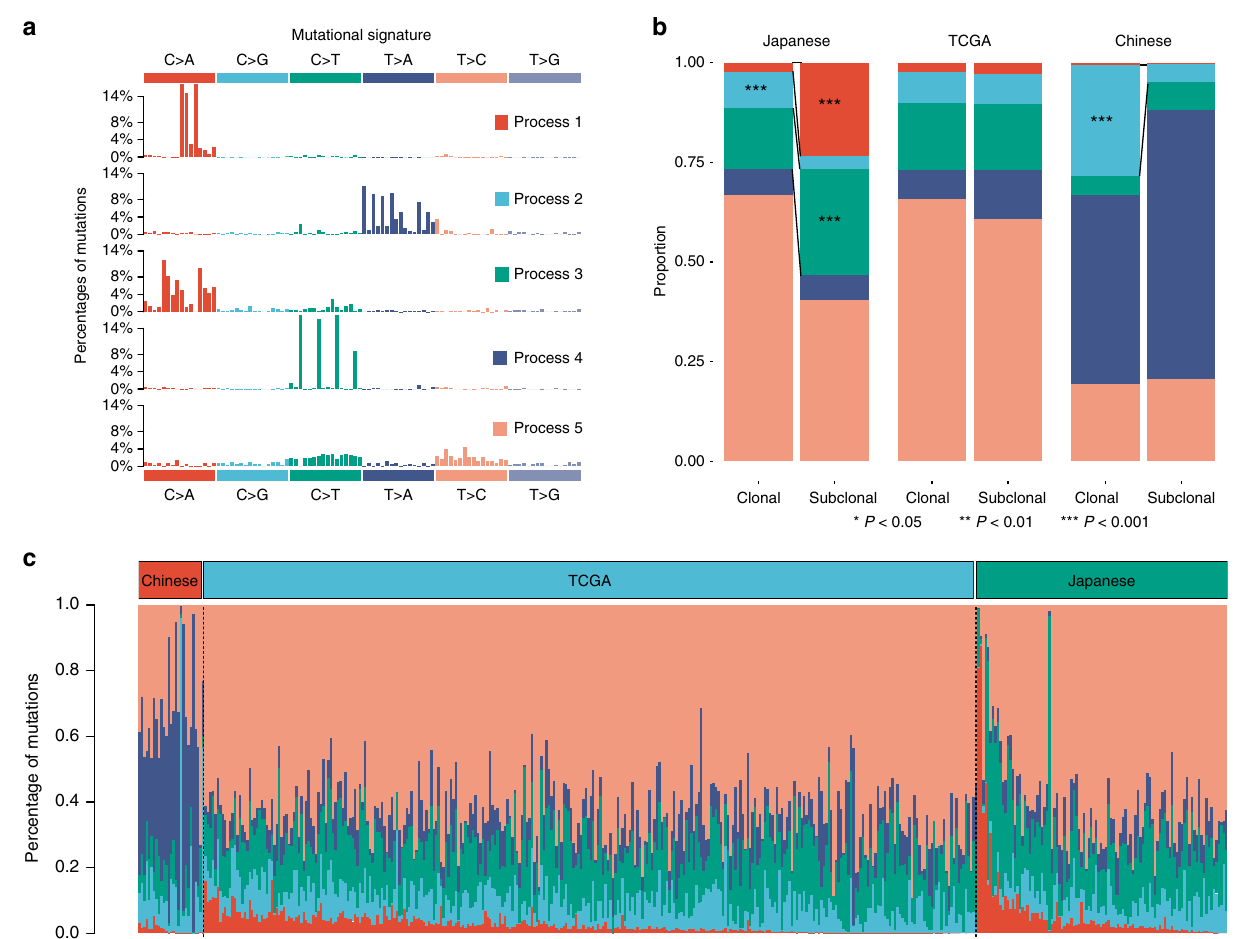
Fig. 1 The distribution of mutational signatures across different cohorts. a Five distinct mutational signatures identi fi ed by NMF analysis of the matrix of mutation proportion across tumors from different populations. b Comparison of mutational signatures between clonal and subclonal mutations. Enrichment of mutational signatures between clonal and subclonal mutations was determined by Fisher test of the relative contribution of each signature in all patients. c Mutational exposures (number of mutations) attributed to each mutation signature in each